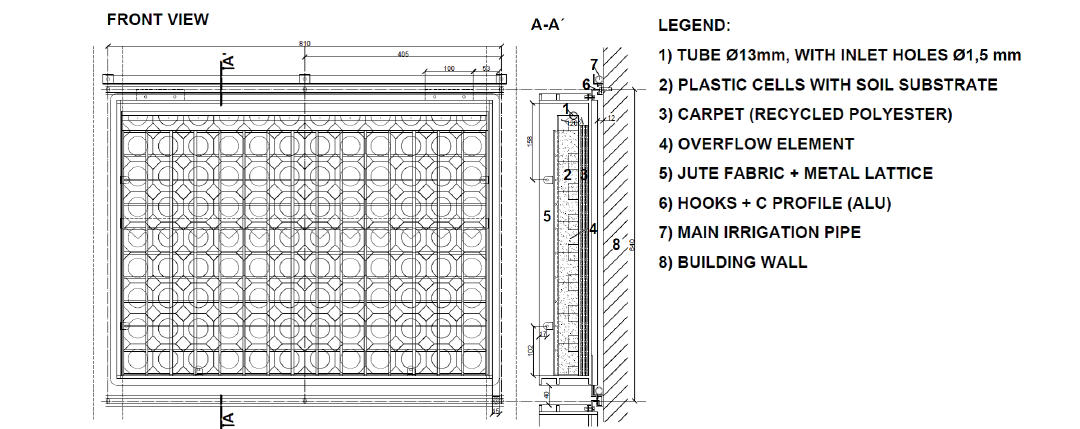
Figure 2. Technical drawing of test sample nr. 3.